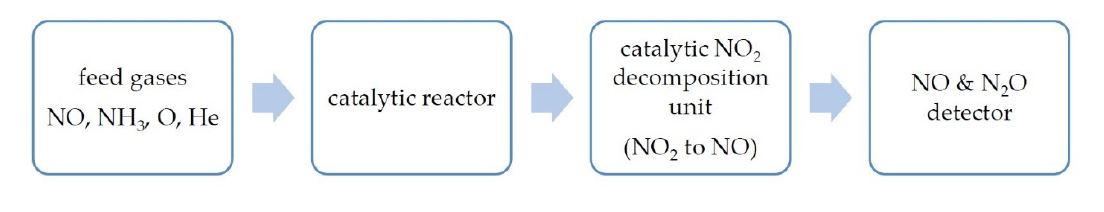
Figure 12. Catalytic setup.